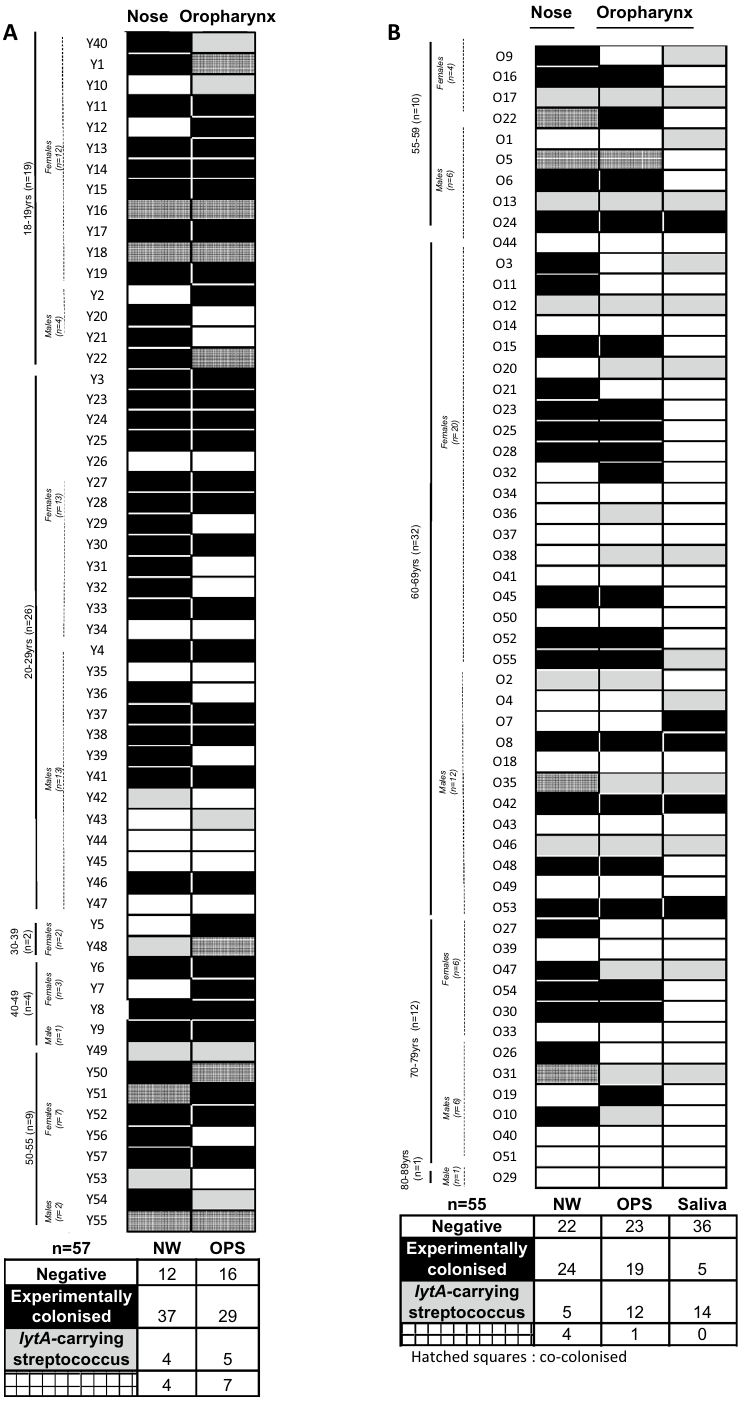
Figure 2. Heatmap showing individual nasal and oropharyngeal profiles in ( A ). young (18–55 years, n = 57) and ( B ) older (> 55 years, n = 55) adults. Participants are colour coded; white squares qPCR-negative, black squares Spn6B + , grey squares lytA + and hatched squares co-colonisers. Data is broken down by age group and gender. More Spn6B + participants were detected in nose (NW) than oropharynx (OPS) in both age groups (Young: NW n = 41 vs OPS n = 36, Older: NW n = 28 vs OPS n = 20). Pneumococcal presence in both NW (Young n = 41 vs Older n = 28, *P = 0.026) and OPS (Young n = 36 vs Older n = 20, **P = 0.008) was statistically significantly different between young and older adults (GLM model). In older adults, fewer Spn6B + participants were detected in saliva (n = 5). Heatmaps were created in Microsoft Excel (2016), Microsoft, USA, www. micro soft.